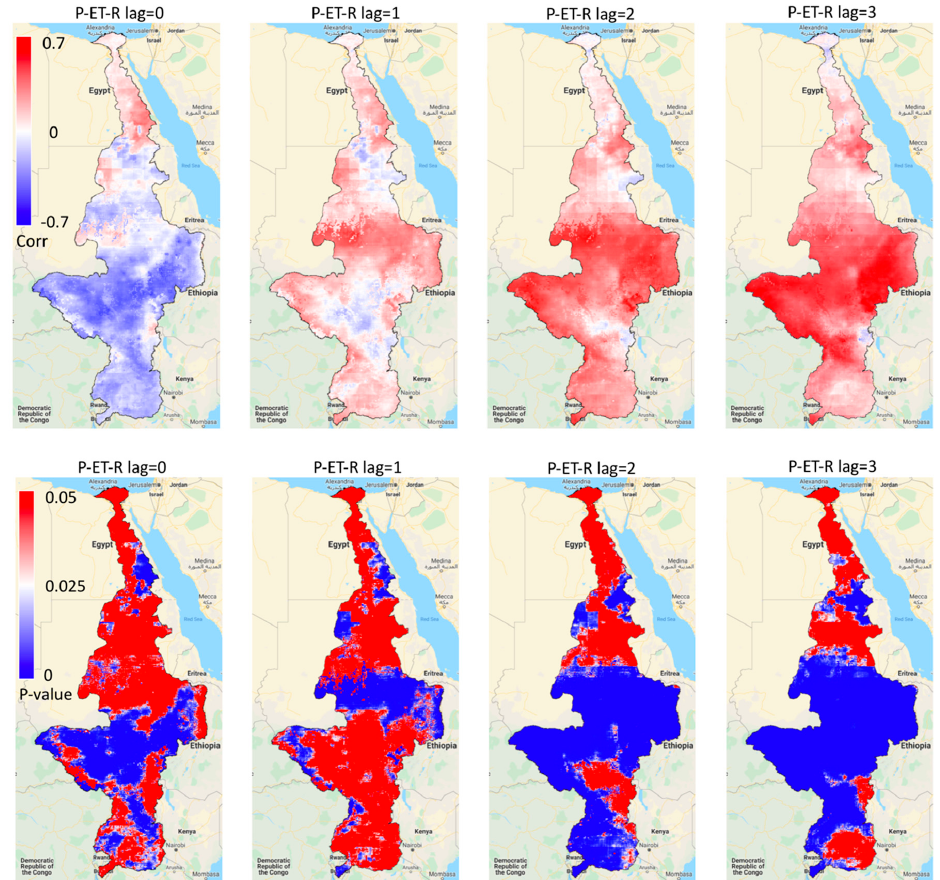
Figure 6. The correlation maps (correlation coefficient and p-value, up to 3 months of lags apart) between LWE and P-ET-R (precipitation minus ET and runoff) over the Nile watershed calculated based on Pearson correlation analysis of the periods between the years 2002–2017.